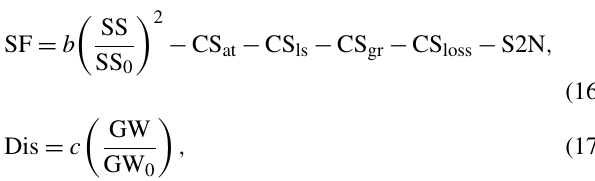
Figure 15. Stock and flow diagram of the water